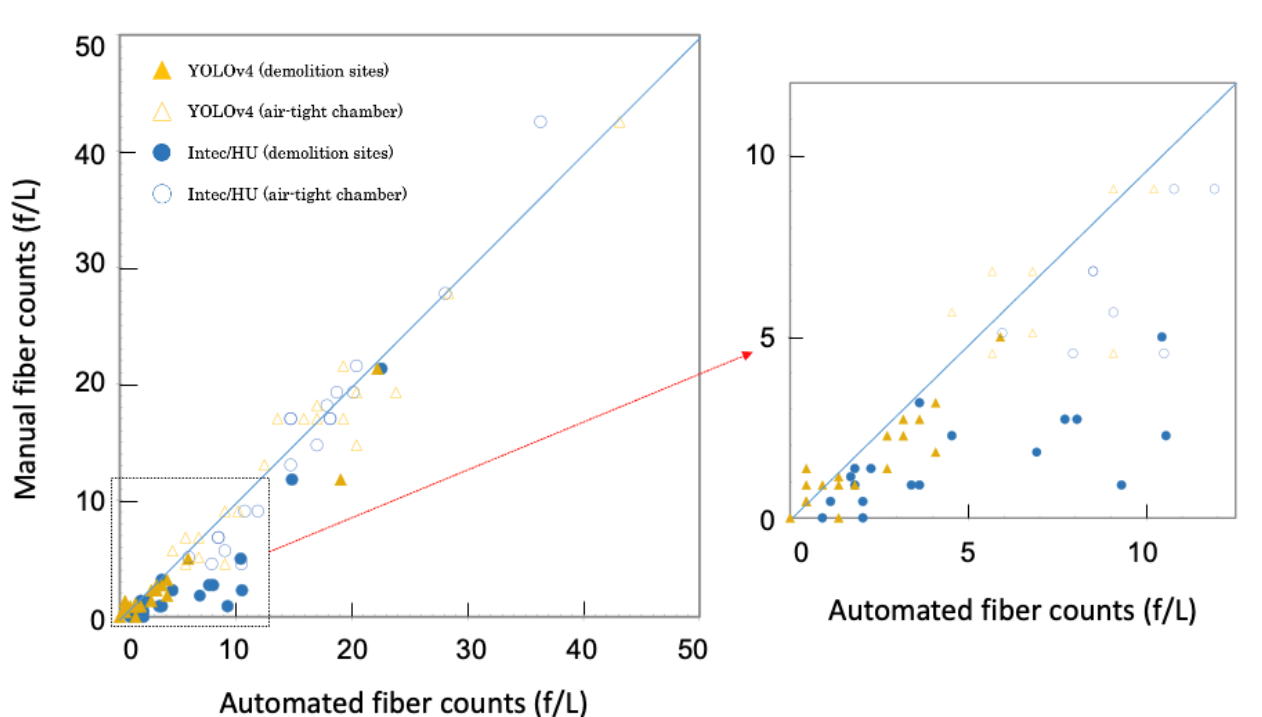
Figure 5. Correlation between manual and automated fiber counts at ( a ) the wide range of fiber concentrations (0 – 50 fibers/liter, f/L) and ( b ) low fiber concentrations (<15 f/L). The dotted area in ( a ) was enlarged in ( b ). Shaded and open triangles (brown) represent data points analyzed by YOLOv4 at threshold value of 0.7 with dust samples at demolition sites and relatively pure asbestos minerals, respectively. Shaded and open circles (blue) represent data points analyzed by Intec/HU asbestos software with dust samples at demolition sites and relatively pure asbestos minerals, respectively.